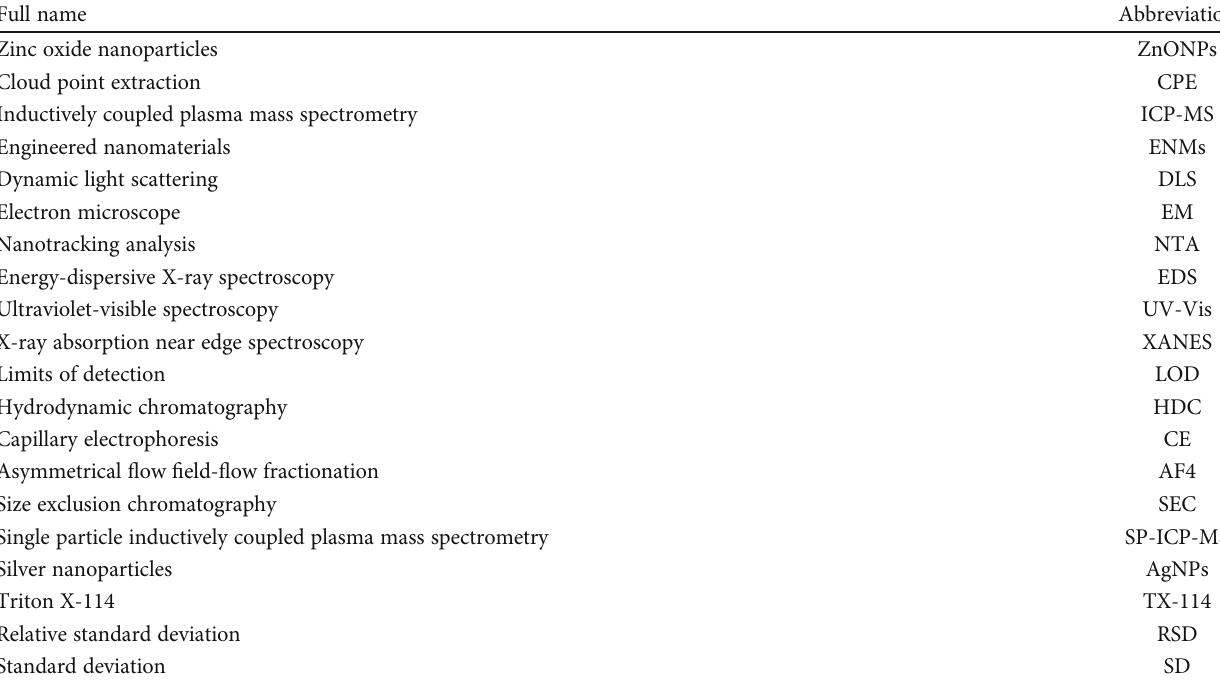
Table 1: List of abbreviations.